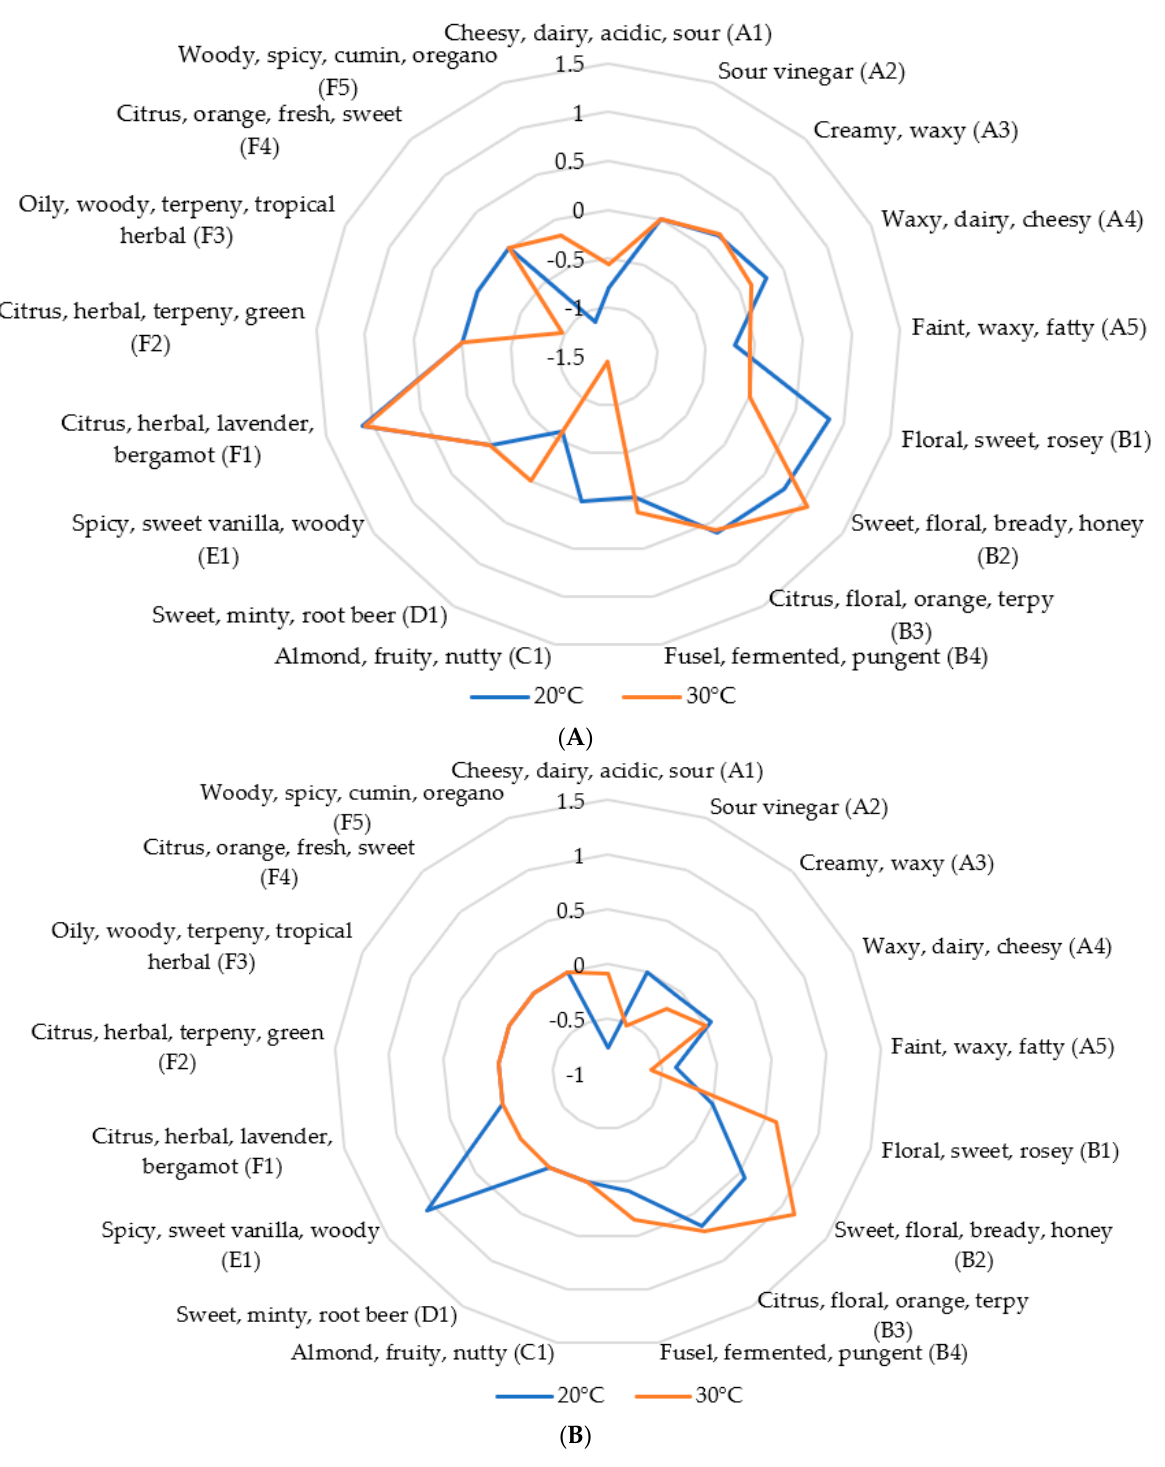
Figure 7. Variation of the estimated sensory profile (expressed as the log of OAV; OAV = concen- tration/ perception threshold) of the most representative volatile compounds (%area > 1%) with temperature ( ◦ C) on kombucha fermentation in the ( A ) intermediate stage (D7) and ( B ) the final stage